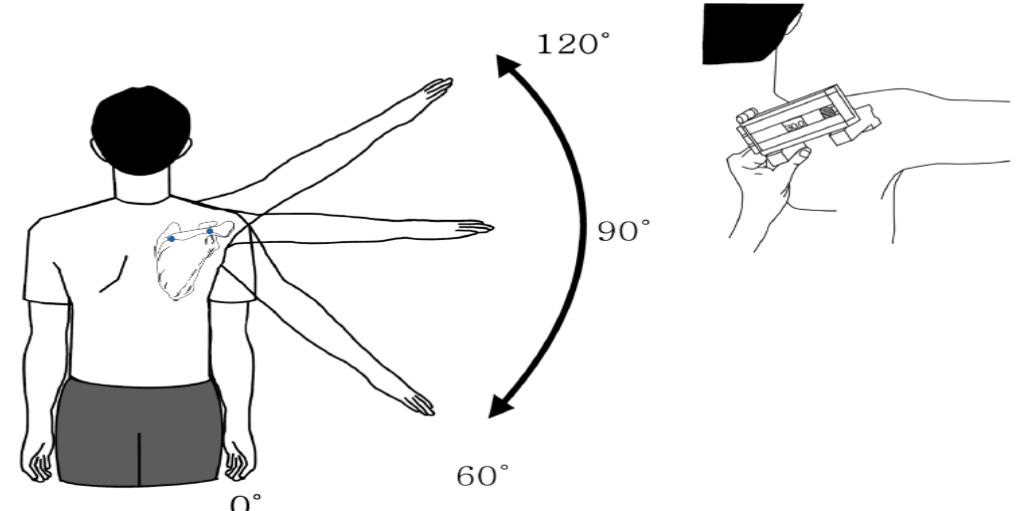
Figure 1. Measurement of scapular upward rotation (°) by humeral elevation.